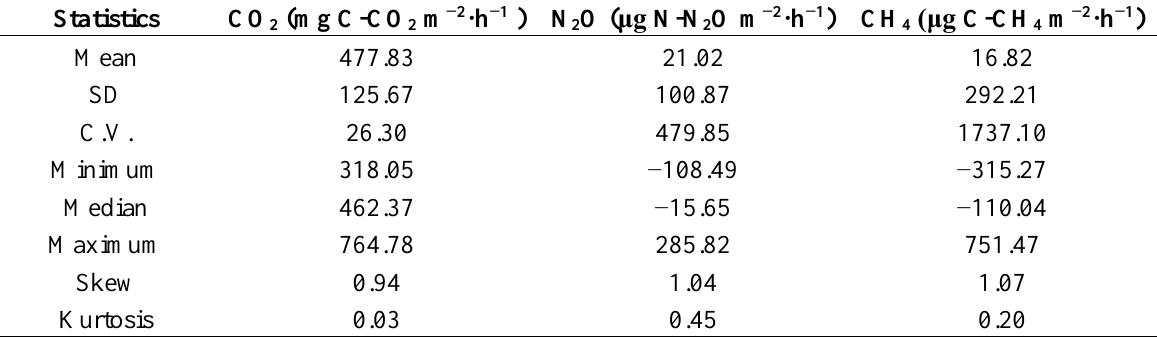
Table 2. Descriptive statistics for CO 2 , N 2 O and CH 4 fluxes in